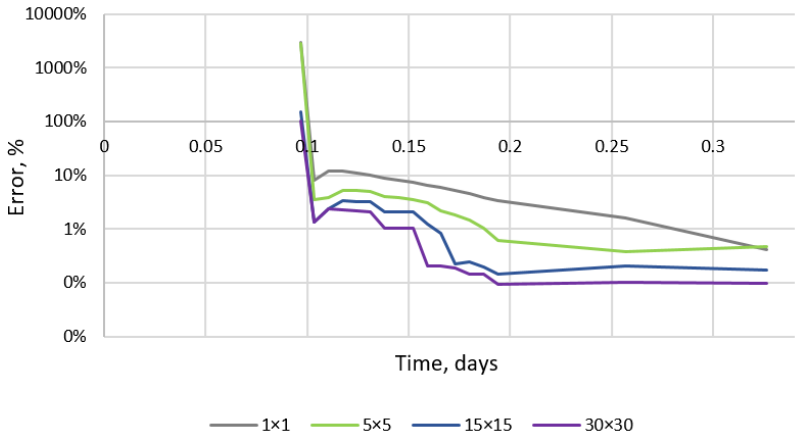
Figure 12. Error relative to the ideal (60 × 60) oil yield.